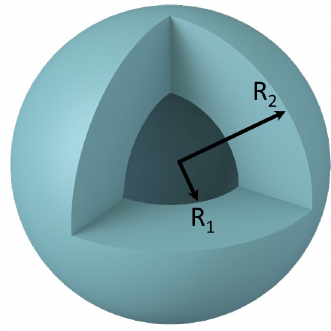
Figure 1. Spherical nanoshell with inner radius R 1 and outer radius R 2